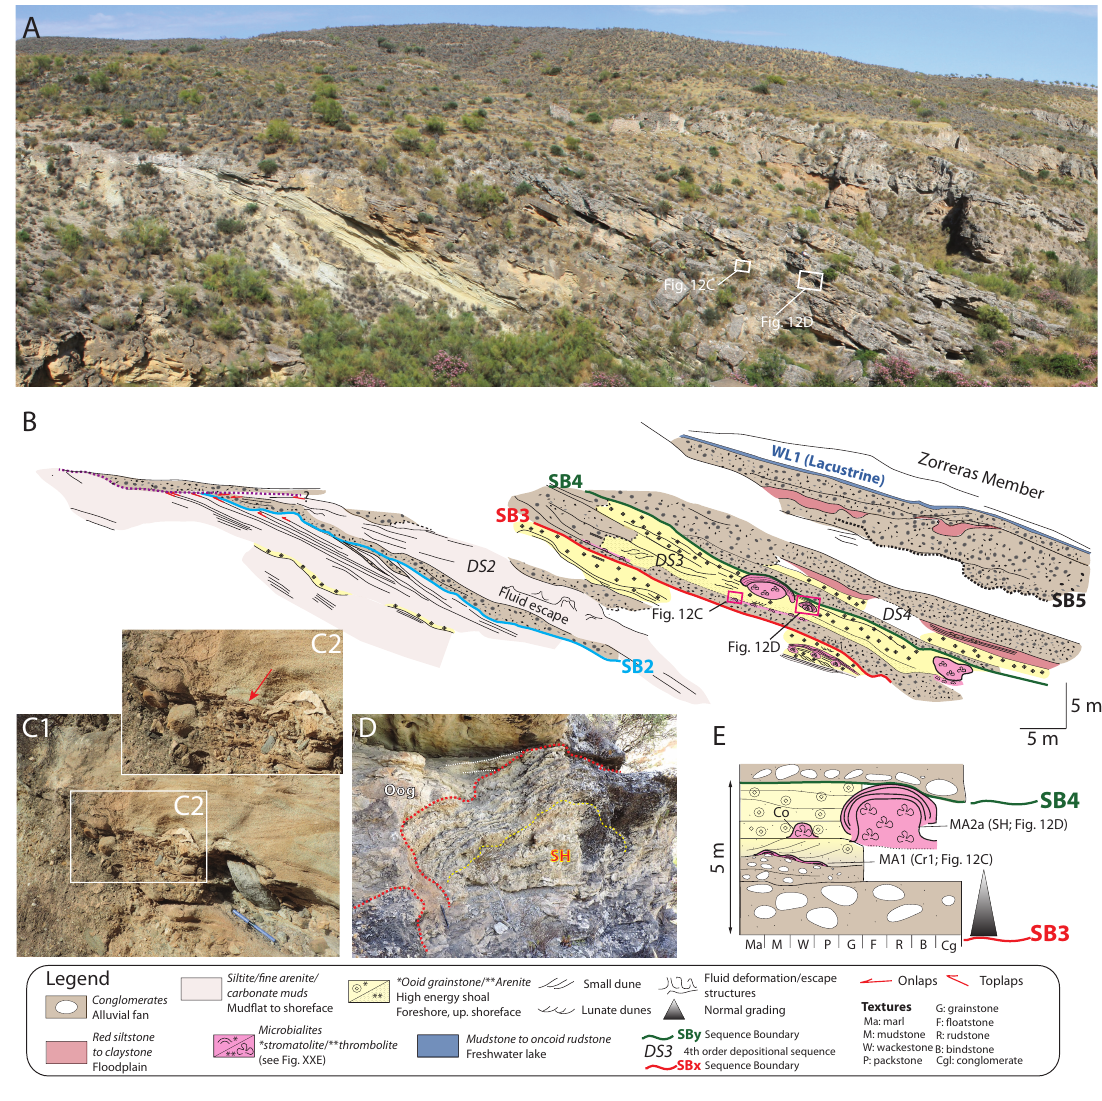
Figure 12. Stratigraphic architecture of the TCC and microbialites occurrences in the Rambla de G ó char. ( A ) Photomosaic and ( B ) interpretation of the geometry and facies of the southern part of the TCC outcrop in the Rambla de G ó char. ( C 1) Close-up view of ( A ) and ( B ) showing a stromatolite crust (red arrow) covering alluvial fan conglomerates. The crust itself is overlain by a dune composed of arenites. The pencil for scale is 15 cm long. ( C 2) is an enlargement of ( C 1) showing the laminated mesofabric of the crust. ( D ) Close-up view of ( A ) and ( B ) showing a large stacked hemispheroid (SH) surrounded by ooid grainstones (Oog; white dotted lines). The pencil for scale is 15 cm long. ( E ) Synthetic sedimentary section of Depositional Sequence 3 in the G ó char area, with relationships between the microbialite associations and other sedimentary